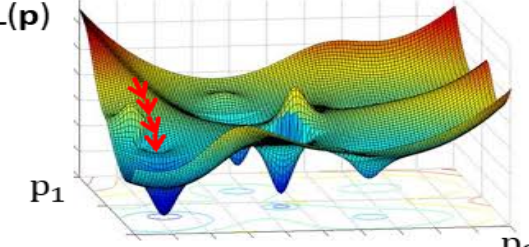
Figure 3. Graphical illustration of two-dimensional non-convex loss function L ( p ) . Red arrows indicate the directions of parameter updating while searching for the minima.